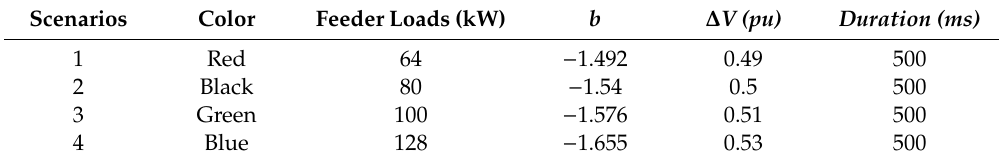
Figure 9. Voltage sag magnitude of the four simulated scenarios with different feeder-load values. Table 2. Simulated scenarios and resulting parameters of Section